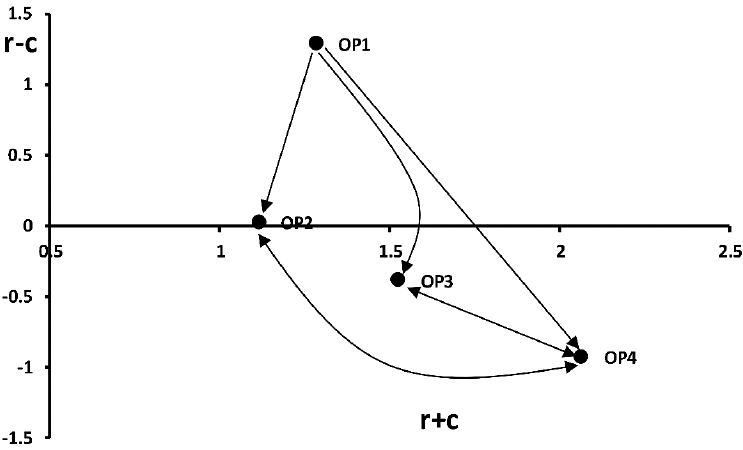
Figure 3. The cause and effect relationship map for operation FMs. Figure 3 . The cause and effect relationship map for operation FMs.